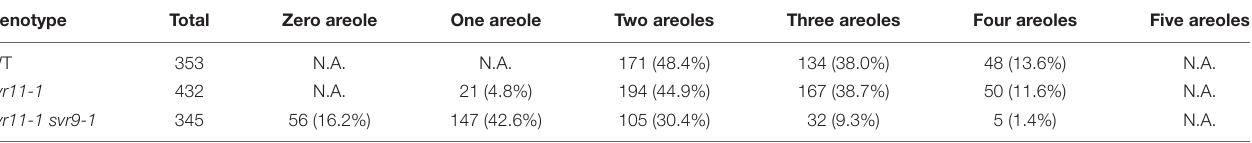
TABLE 2 | Quantification of cotyledon vein patterns in wild type, svr11-1 and svr11-1 svr9-1 .